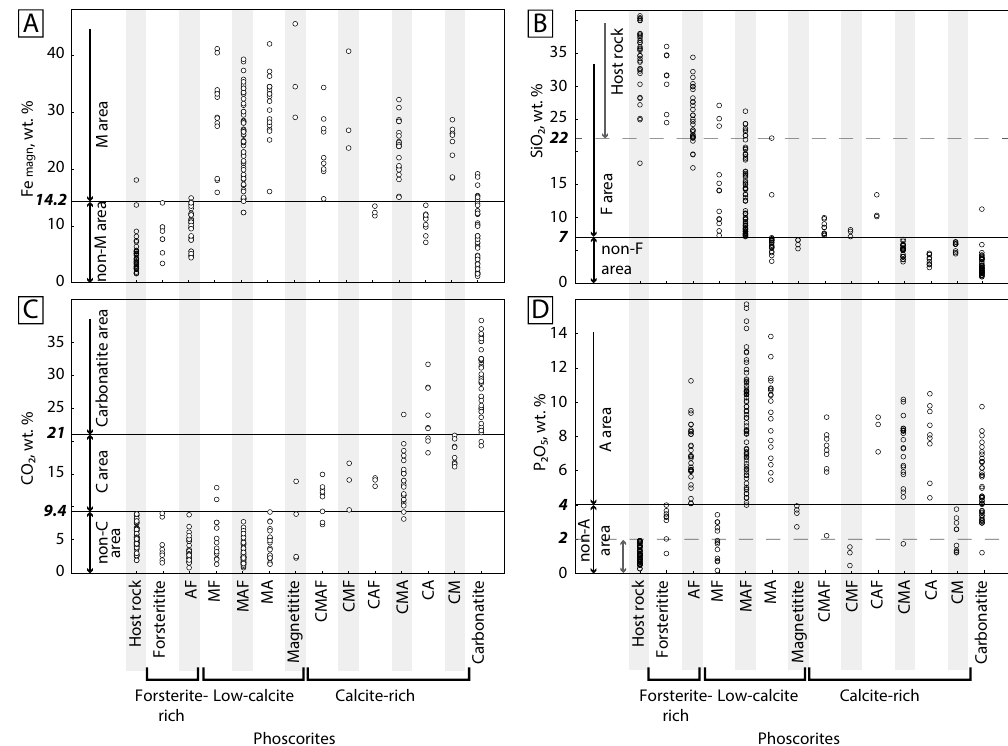
Figure 3. Boundaries between phoscorite types, carbonatite and host rocks in terms of bulk-rock chemistry. X-axis is rock name (letters C, M, A, F are mineral indexes in phoscorite name: calcite, magnetite, apatite and forsterite, correspondingly, classification is shown in Fig. 2). Y-axis is chemical composition of rocks; bold numbers are values for logical evaluation of a rock type (Fig. 4).